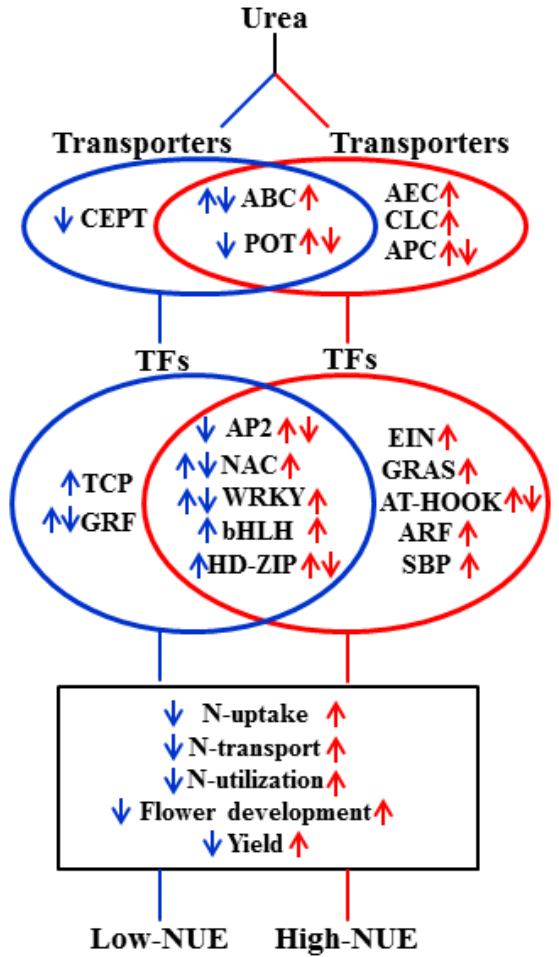
Figure 7. Hypothetical model depicting the important classes of genes and associated pathways